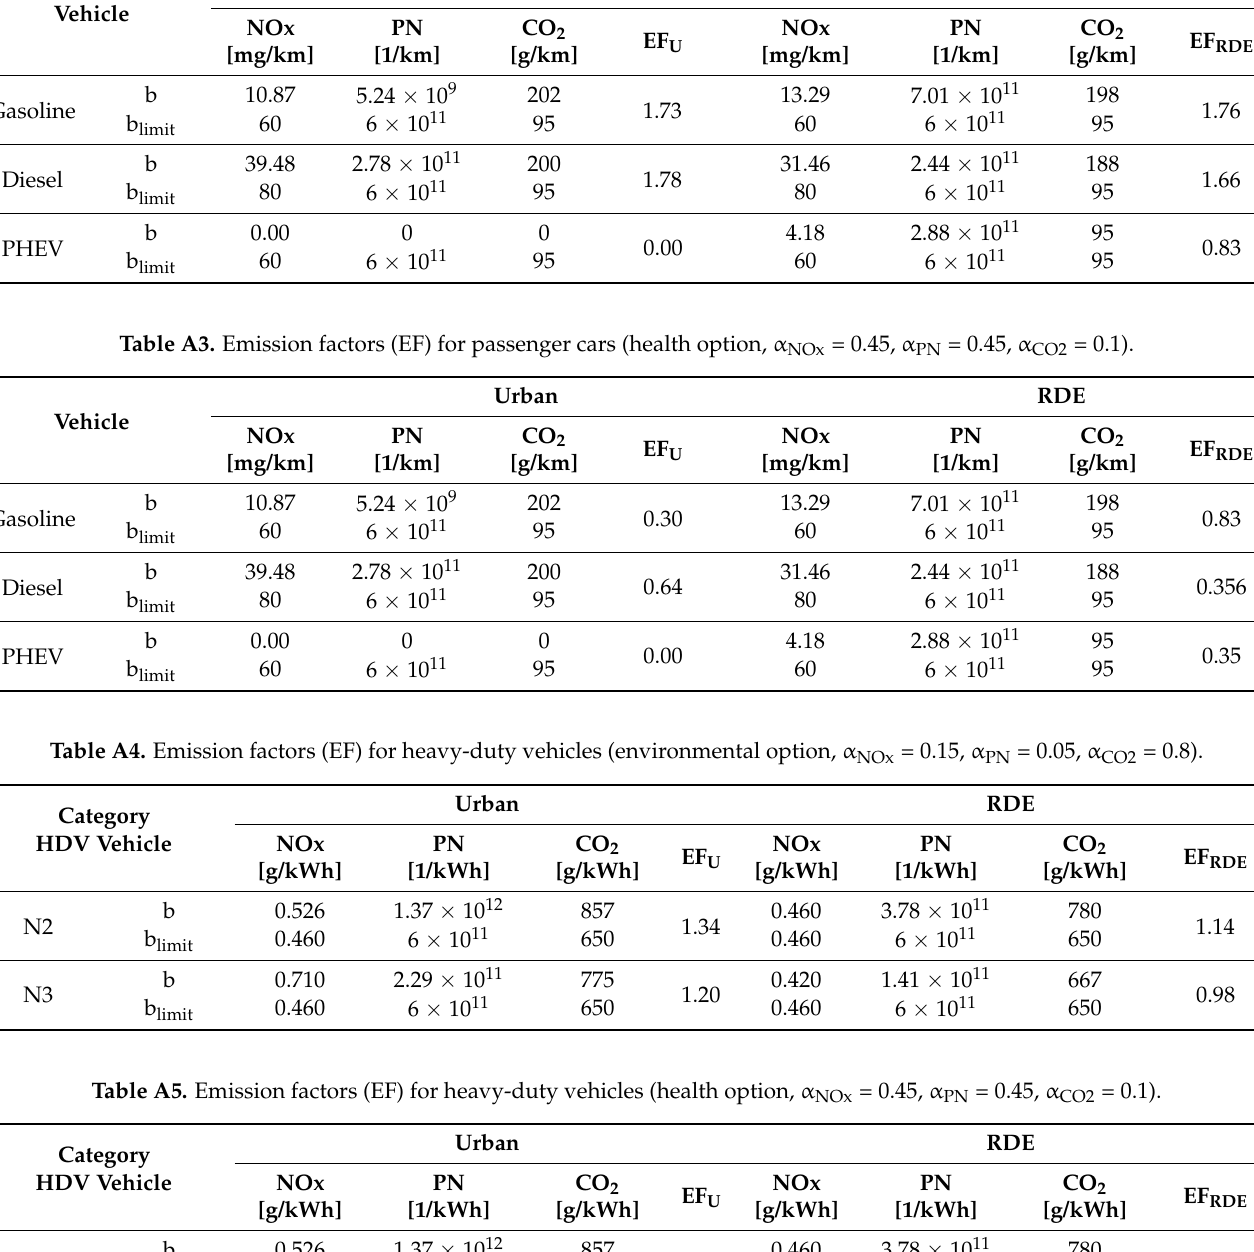
Table A2. Emission factors (EF) for passenger cars (environmental option, α NOx = 0.15, α PN = 0.05, α CO2 = 0.8). Vehicle